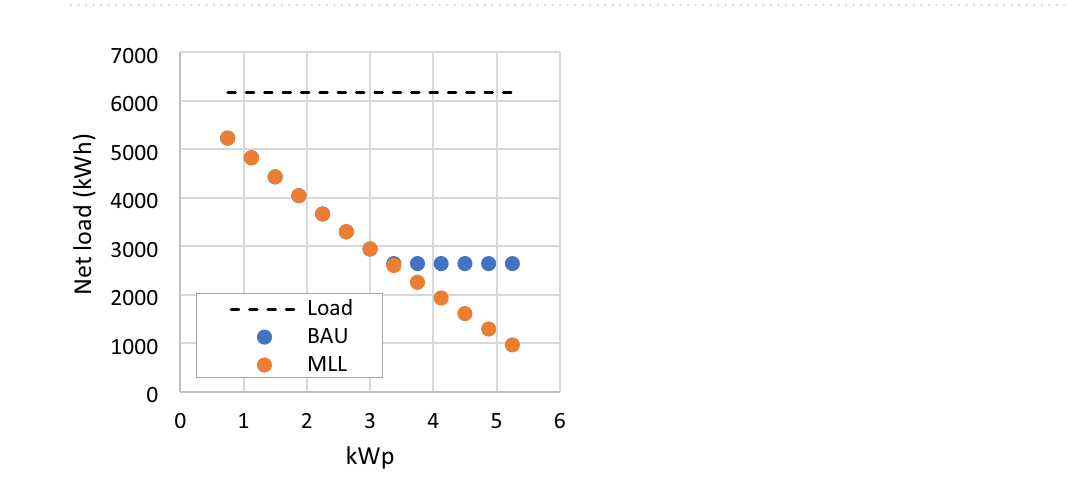
Figure 10. NPV and annual revenue of RSPP with different number of PV modules in BAU and MLL scenario.